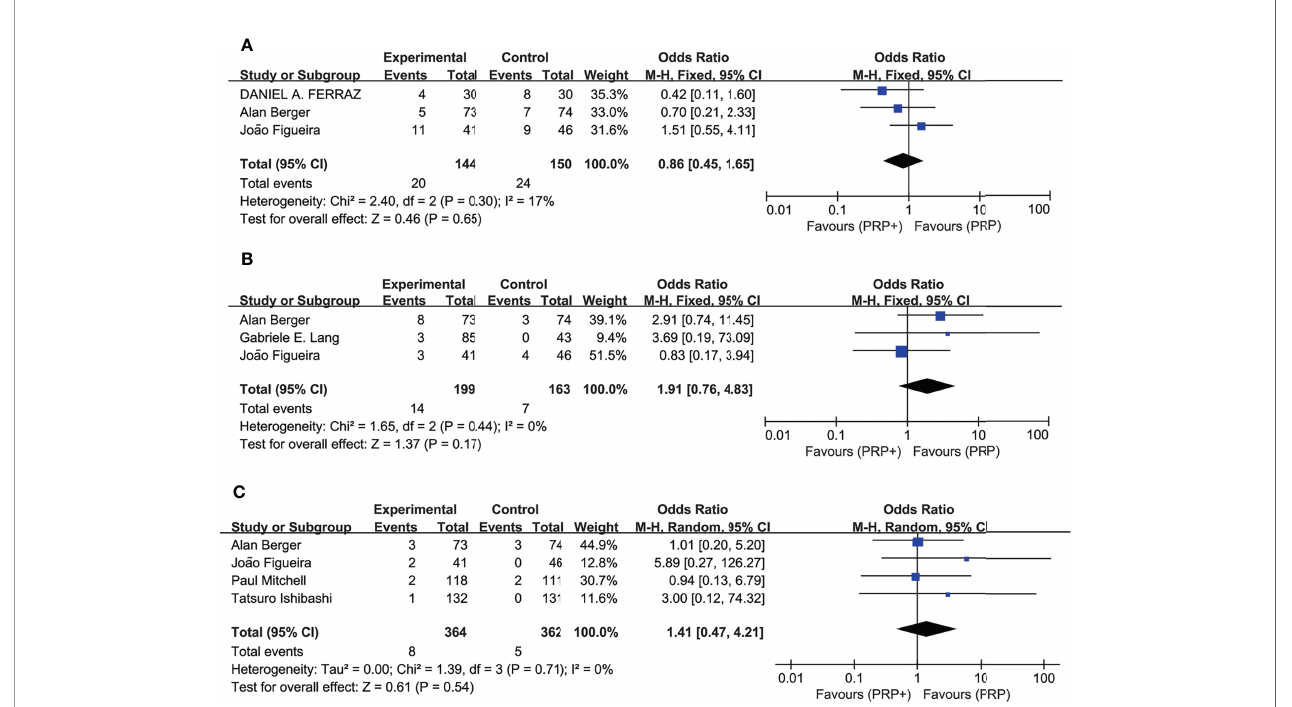
FIGURE 7 | Meta-analyses of PRP+anti-VEGF treatment and PRP monotherapy, comparing incidence of AEs. (A) Vitreous hemorrhage. (B) Elevation in intraocular pressure. (C) Cataract. Outcomes assessed: incidence of vitreous hemorrhage, elevation in intraocular pressure, and cataract in studies that compared combination treatment with PRP monotherapy. The shaded area is the weight of the estimate in proportion to the overall